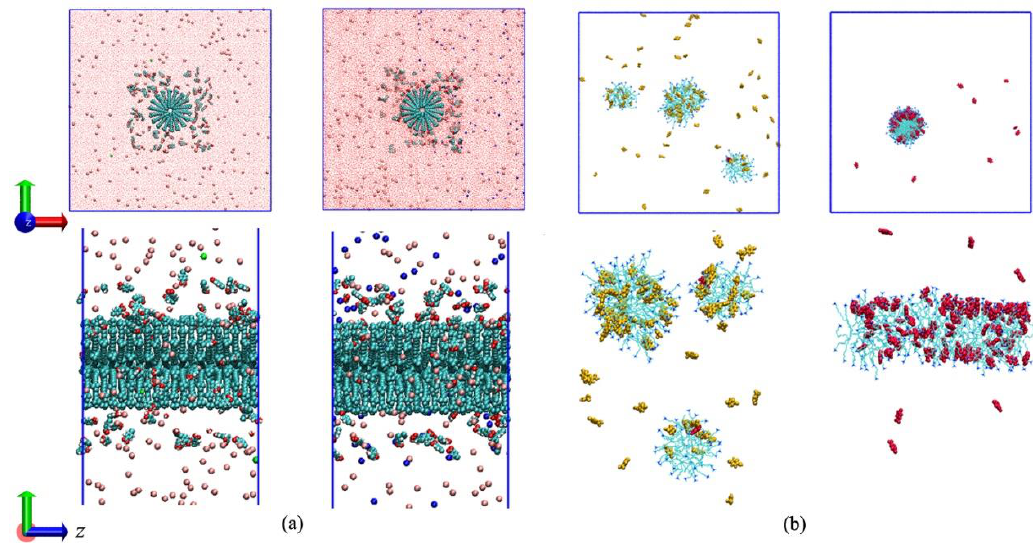
Figure 1. ( a ) Initial setup of the two simulated systems. ( b ) Configurations of CTAB/PTA (pH 2, left in inset a and b) and CTAB/PTA − (pH 7, right in inset a and b) aggregations. The top panel shows the views from the z-axis perspective. The solid blue lines represent the periodical boundary conditions. Water molecules and inorganic ions are hidden in inset b for clarity. The neutral forms PTA and ionized PTA − are displayed in yellow and red, respectively.